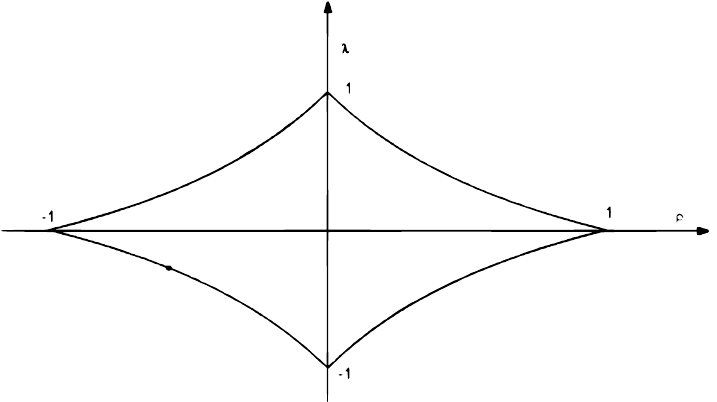
Figure 1. The parameter space Λ of λ and ρ